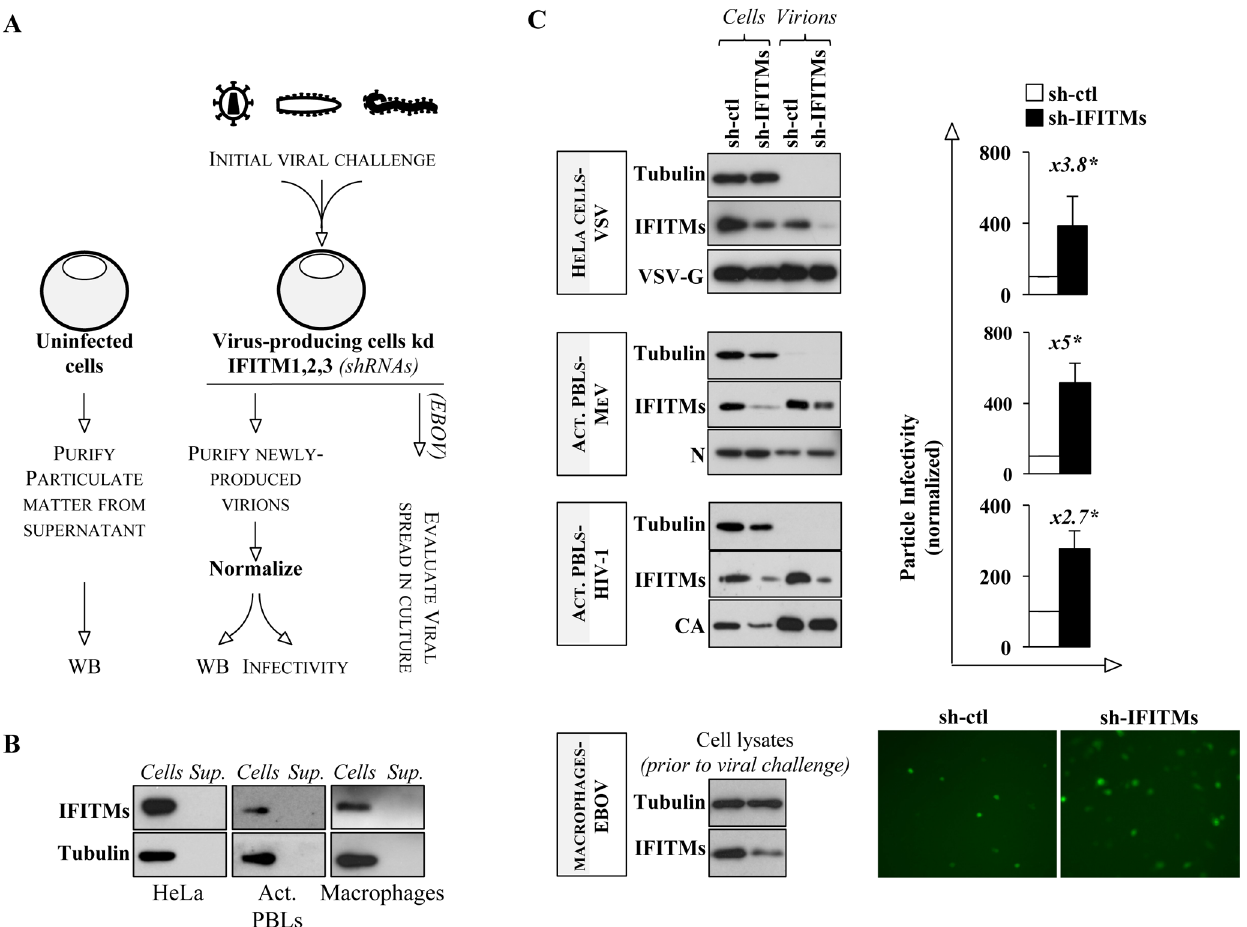
Fig 6. Silencing of endogenous IFITMs increasesthe infectivity of virions of different viruses and increasesEBOV spread in primary macrophages. A) Endogenous IFITM1, 2 and 3 were silencedby shRNA-mediated lentiviral transduction alongwith shRNA-control silenced cells and then treated accordingto the scheme provided. B) Expression and extracellular release propertiesof endogenously-expressed IFITMs in the uninfectedcell types used here (cells and sup., respectively). The basal expressionlevels of IFITM proteins were measured in the cell types mentionedabovewith a pool of anti-IFITM1, 2 and 3 antibodies in cell lysates and supernatantspurifiedby ultracentrifugationthrough sucrose, as viral particles in Fig 2. The same amounts of cells used elsewherefor viral production and in the case of primary cells, the same donorswere used. C) In the case of primary cells, primary blood lymphocytes were stimulated with 1 μ g/ml PHA and 150 U/ml of Interleukin2 (IL2) for twenty- four hours, then challenged with HIV-1 viral vectors expressingeither control (Luciferase),or IFITMs-specific shRNAs and enrichedin knockdown cells followinga three-day selectionin Puromycin(resistance codedby the shRNA vector). Kd-cells were then challengedwith the indicated viruses at MOI comprisedbetween0.1 and 0.5 to obtain virus-producing cells, prior to extensive cell washingto remove input virus.